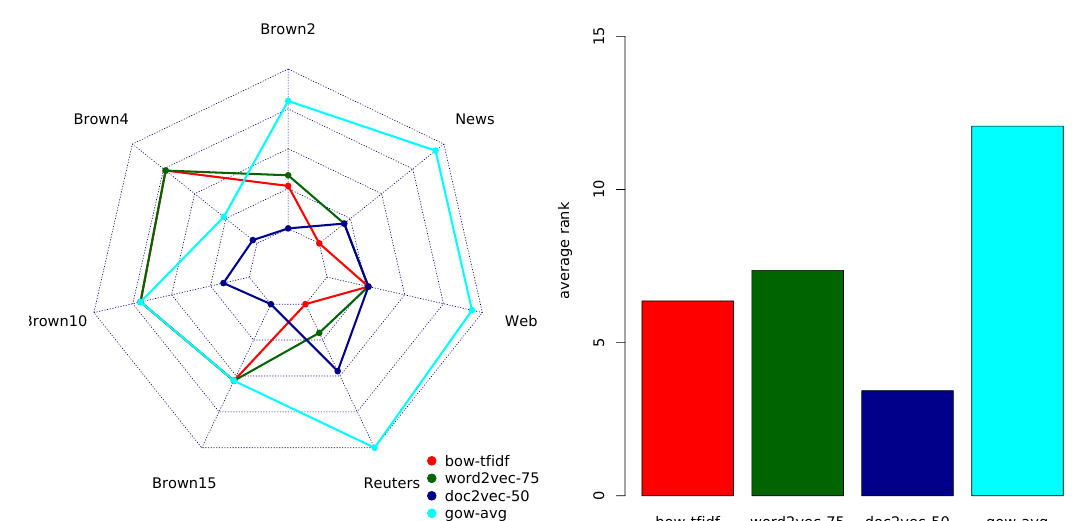
Figure 3. Radar-chart comparison of the multi-objective rankings by task ( left ) and their averages ( right ) for the four top-performing variants of the document representation models in each of the four groups with respect to